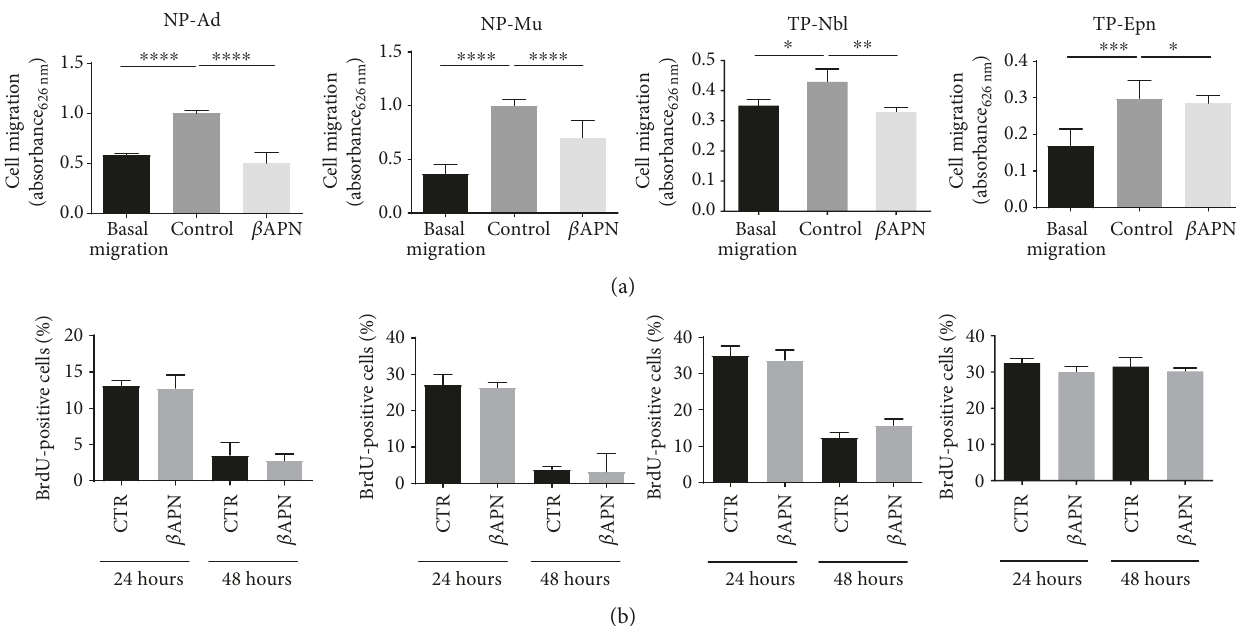
Figure 5: E ff ects of β APN on migration and proliferation of normal and tumor-associated pericytes. (a) Cell migration measured after 24h treatment with 1 μ M β APN. (b) Cell proliferation based on BrdU incorporation after 24 h and 48h treatment with 1 μ M β APN. Normal pericyte samples: NP-Ad and NP-Mu. Tumor-associated pericyte samples: TP-Nbl and TP-Epn. Signi fi cance level: ∗ P < 0 05 , ∗∗ P < 0 01 , ∗∗∗ P < 0 001 , and ∗∗∗∗ P < 0 0001